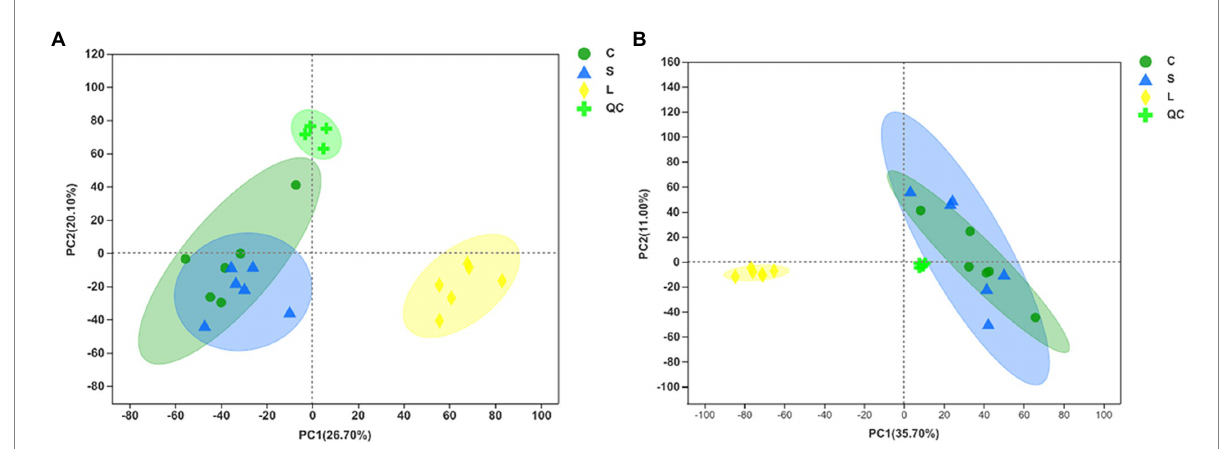
FIGURE 3 Principal component analysis (PCA) of metabolites following positive (A) and negative (B) mode ionization based on metabolomics analysis in the ruminal fluid samples of dairy cows after 48 h in vitro fermentation with two glucogenic and a lipogenic diet. Diets: C, corn and corn silage diet; L,